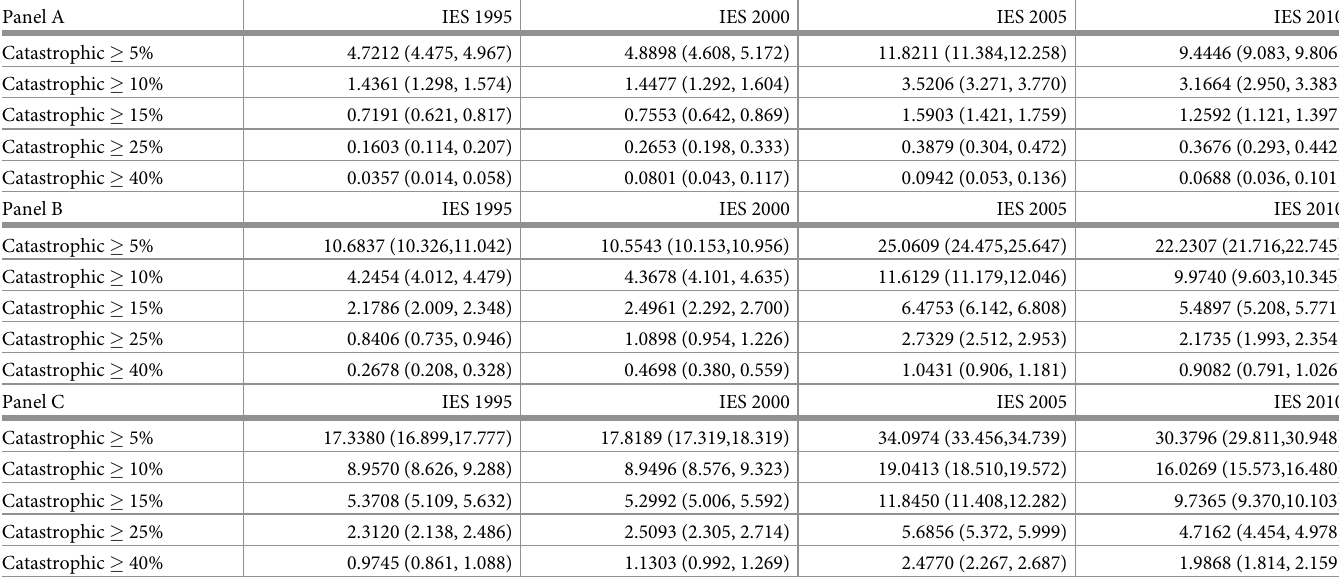
Table 2. The distribution of catastrophic health expenditure over time.